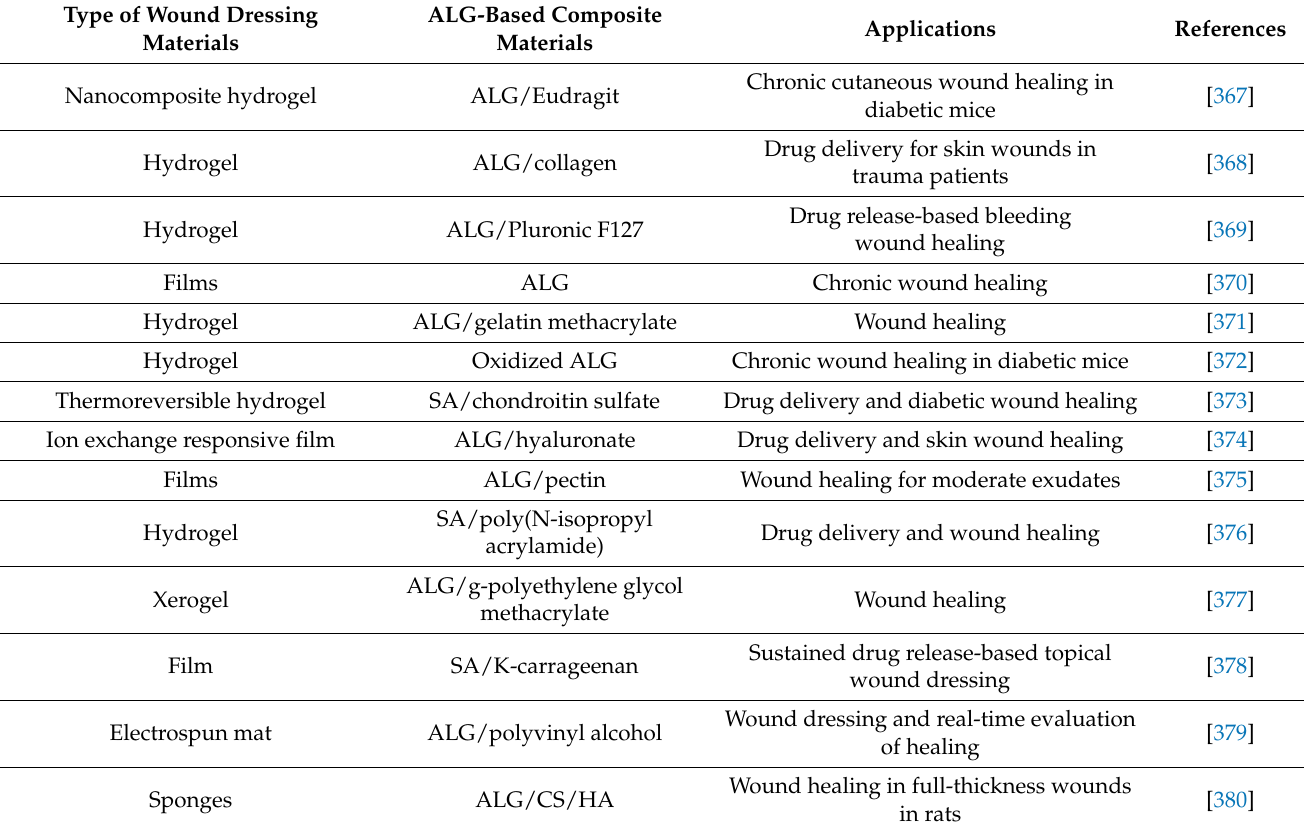
Table 4. Recent investigations of ALG-based composites for wound healing